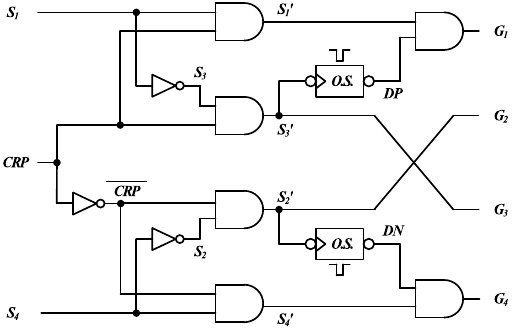
Figure 6. Logical diagram of the proposed switching scheme. Table 2. Conduction mode.